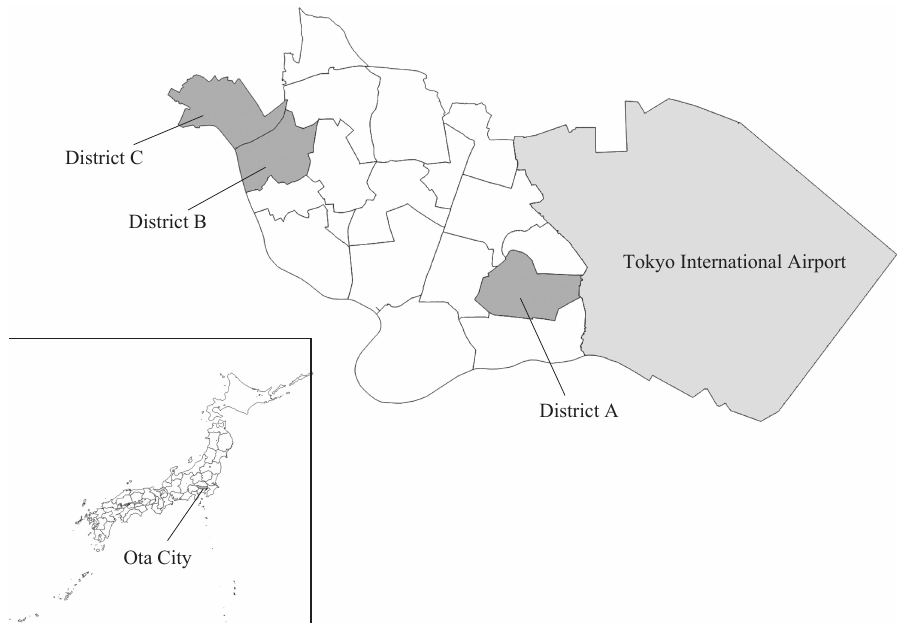
Figure 1. Geographical location of study areas (Ota City, Tokyo,